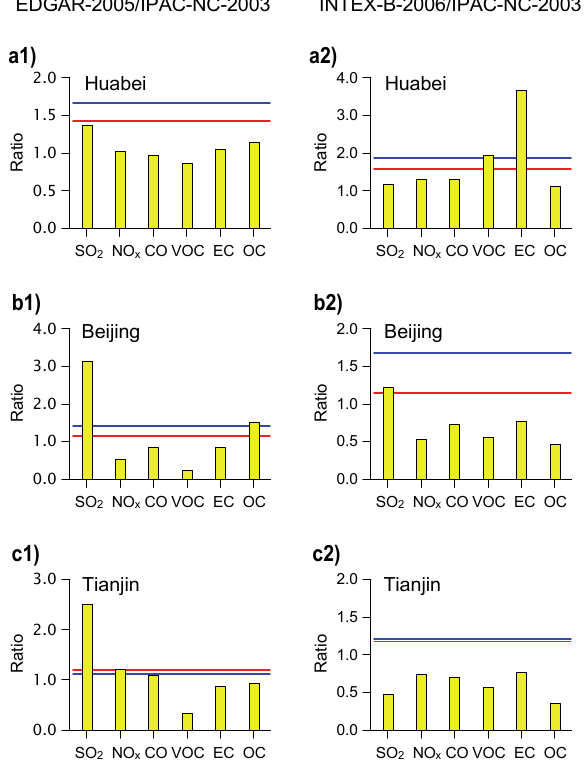
Fig. 10. Ratios of the EDGAR-CIRCE-2005 (1) and INTEX-B- 2006 (2) emission rates to the IPAC-NC-2003 (reference) emission rate of each pollutant (yellow bars), in comparison with the relative increase in energy use from 2003 to 2005 and 2006, expressed by the ratios of the coal (red lines) and gasoline (blue lines) consump- tion, in the larger Huabei region (a) , the Beijing Municipality (b) , and the Tianjin Municipality (c)